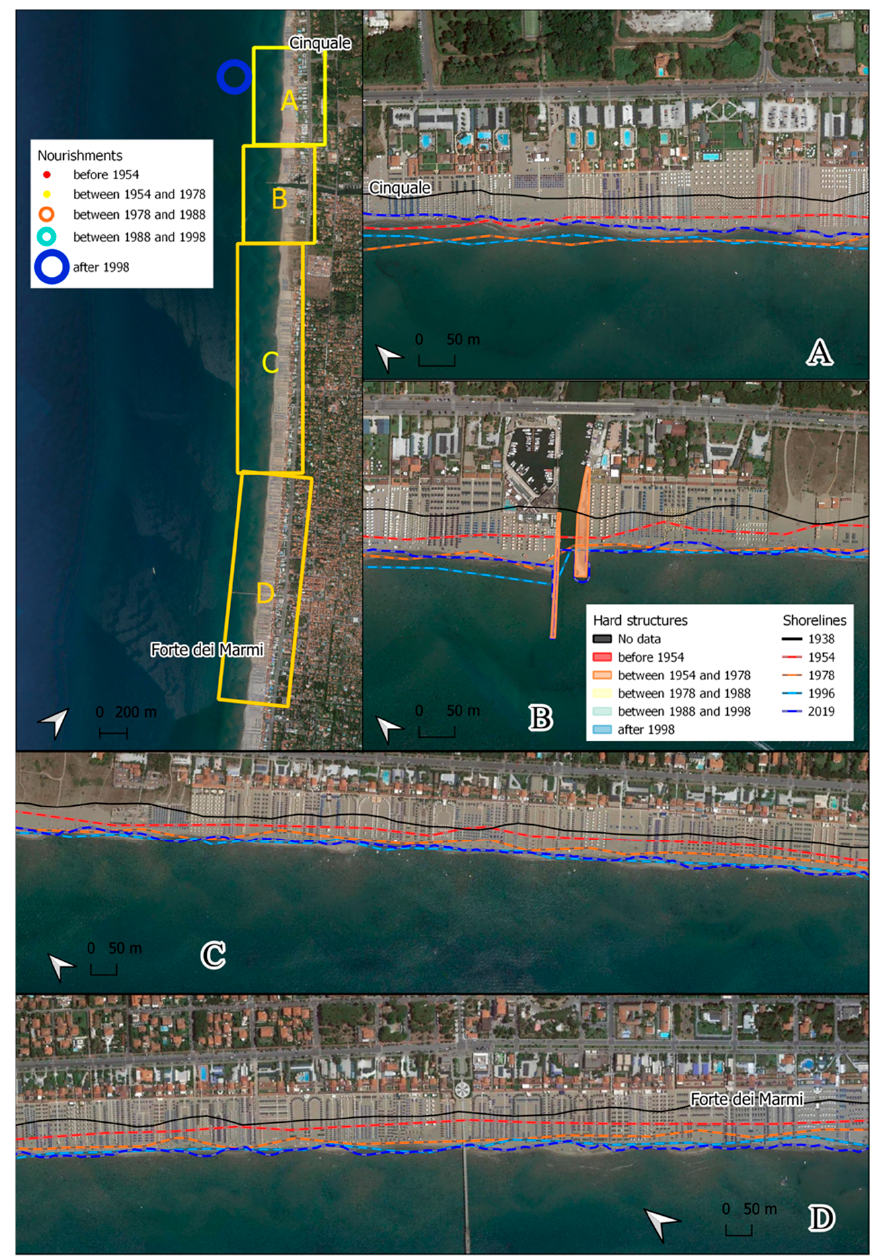
Figure 5. Identification of hard and soft operations along the sector comprised between Cinquale and Forte dei Marmi. Polygons represent the hard structures; dots represent the nourishments. The yellow frames in the top left panel correspond to the zoom in panels to the right and at the bottom. The background image has been retrieved from the Google Earth database.